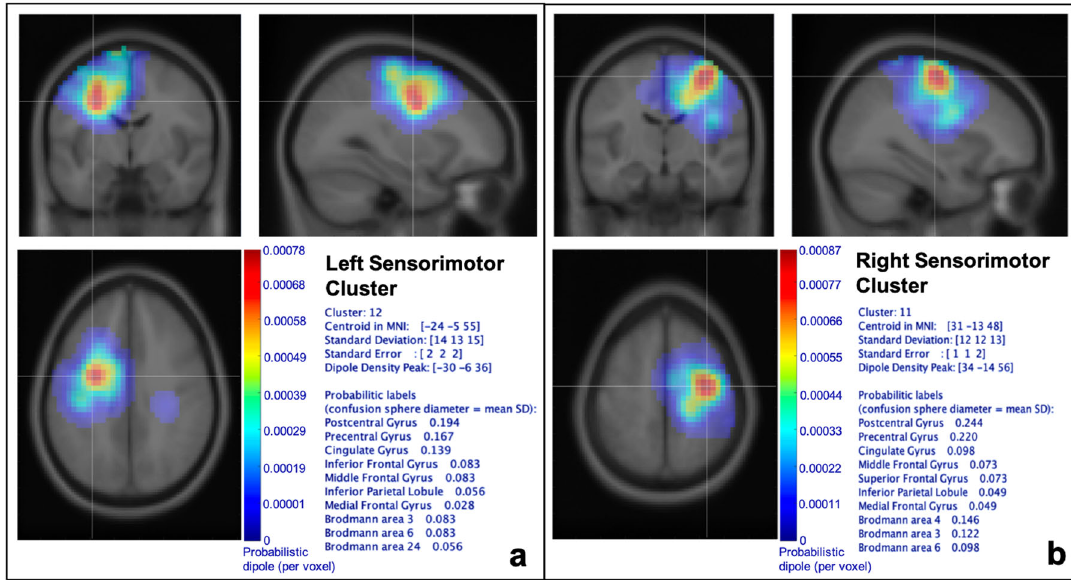
Fig. 4 Independent component clusters in sensorimotor cortices. a Left and b right sensorimotor clusters. Component clusters were visualized using the EEGLAB plugin std_pop_dipoledensity , with a Gaussian smoothing kernel set to FWHM = 15 mm. The probabilistic labels are determined using a confusion sphere centered on the dipole density peak. The diameter of the sphere is the mean of the standard deviation of the centroid in MNI space, and the labels represent the regions with the highest dipole concentration in the cluster, listed fi rst by anatomical label and then by Brodmann area.